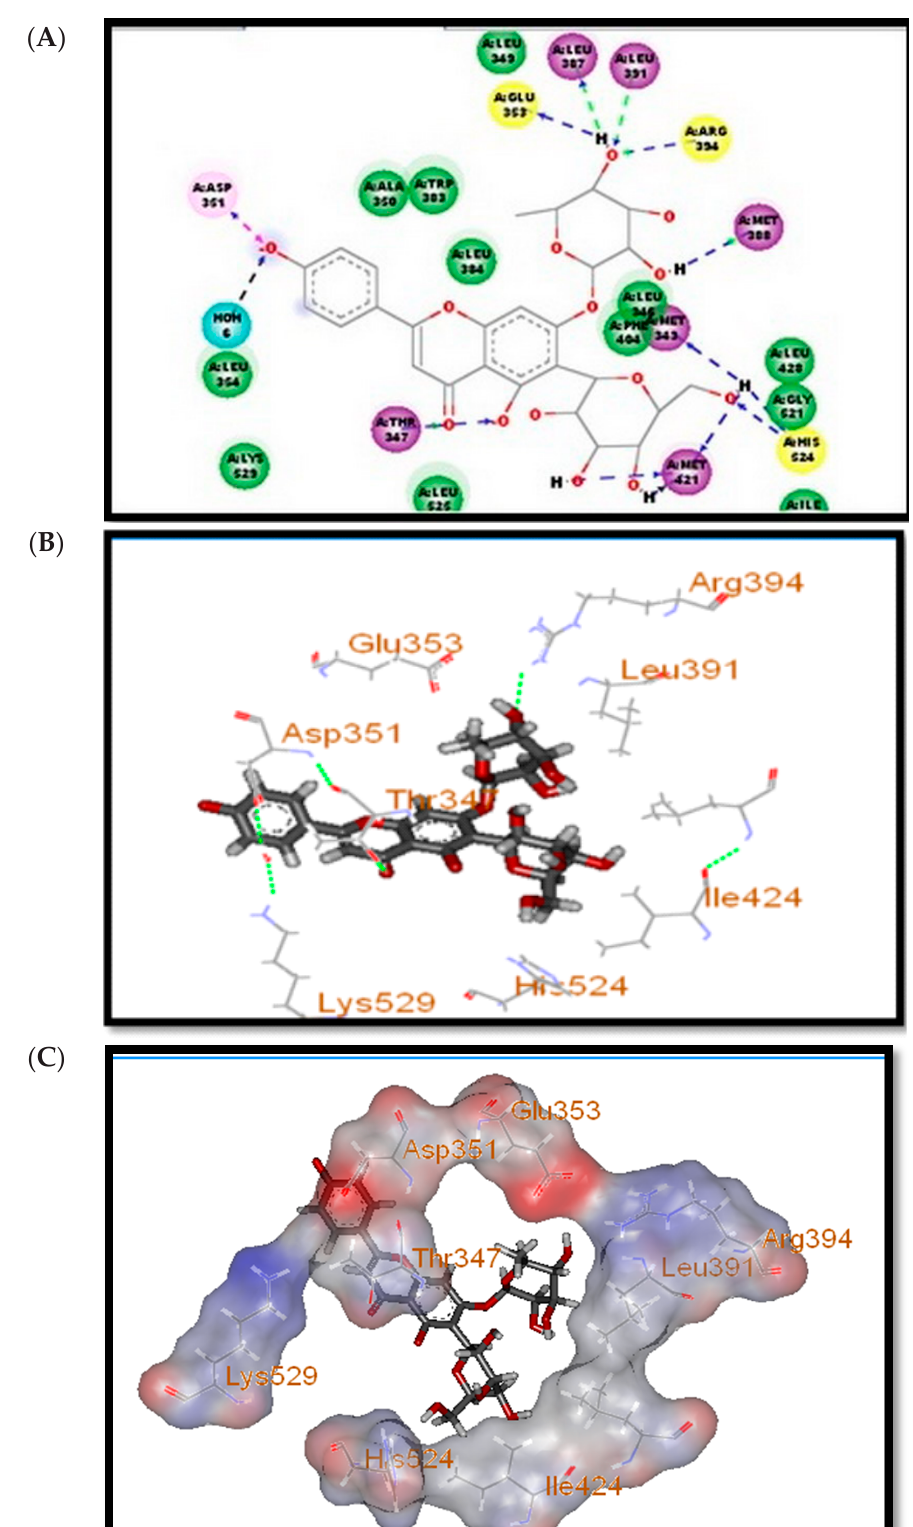
Figure 2. Binding mode for apigenin-7- O -rhamnosyl-6- C -glucoside on human estrogen receptor R.